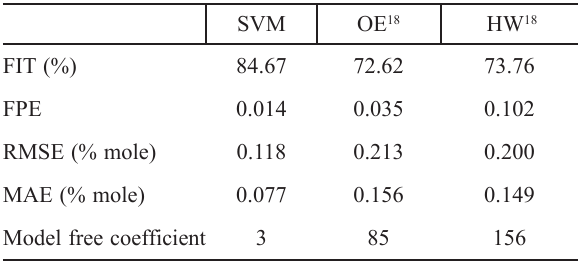
Table 10 – 2,3-DMB content model evaluation